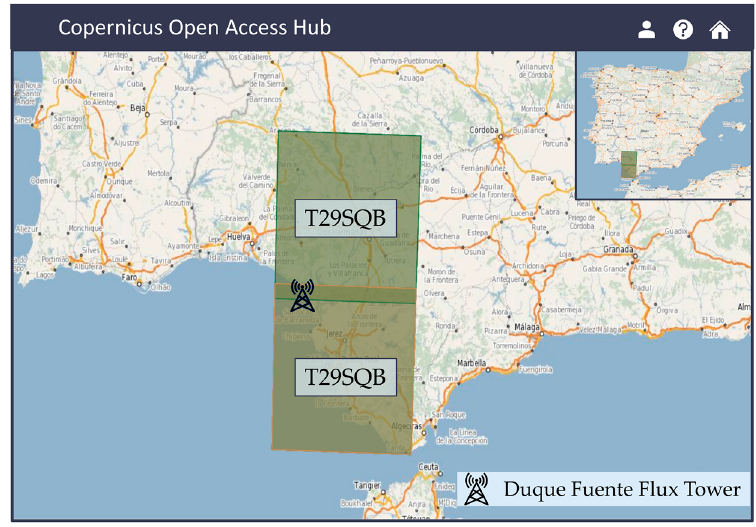
Figure 2. Tiles of Sentine-2 products over the study area of Doñana National Park. [Image retrieved from the Copernicus Open Access Hub].